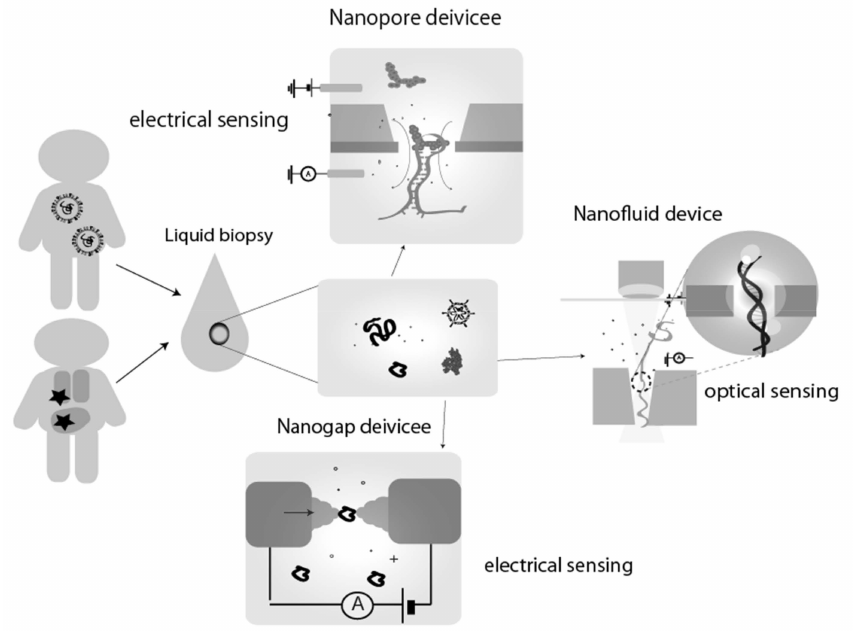
Figure 1. Schematics of single-molecule detection by nanodevices for biological/medical application. In personalized medicine, non-invasive liquid biopsy (urine, blood, etc.) is expected to be used for the application of sampling. The samples include miRNAs and proteins released from the liposomes of cells, as well as the virus itself in case of infection. The target markers in these samples are electrically measured at the single molecule level using nanodevices, such as nanopores, nanogap electrodes, and nano fluid/channels. As single-molecule detection methods, electrical and optical and its combination measurements have been